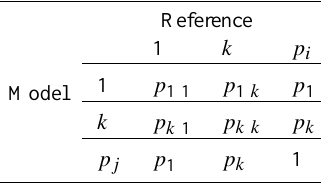
Table 2. Error matrix used for Kappa statistics.